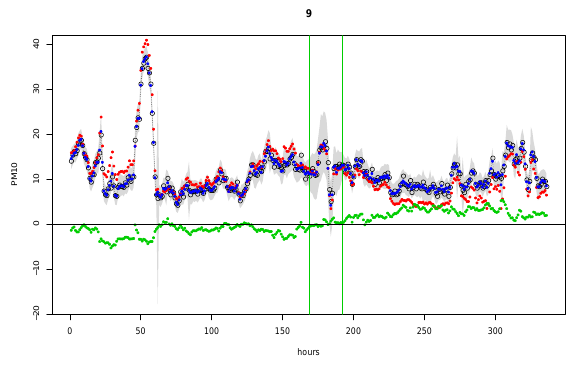
Figure 5. Predictions of PM10 at Airbox 9. Vertical lines